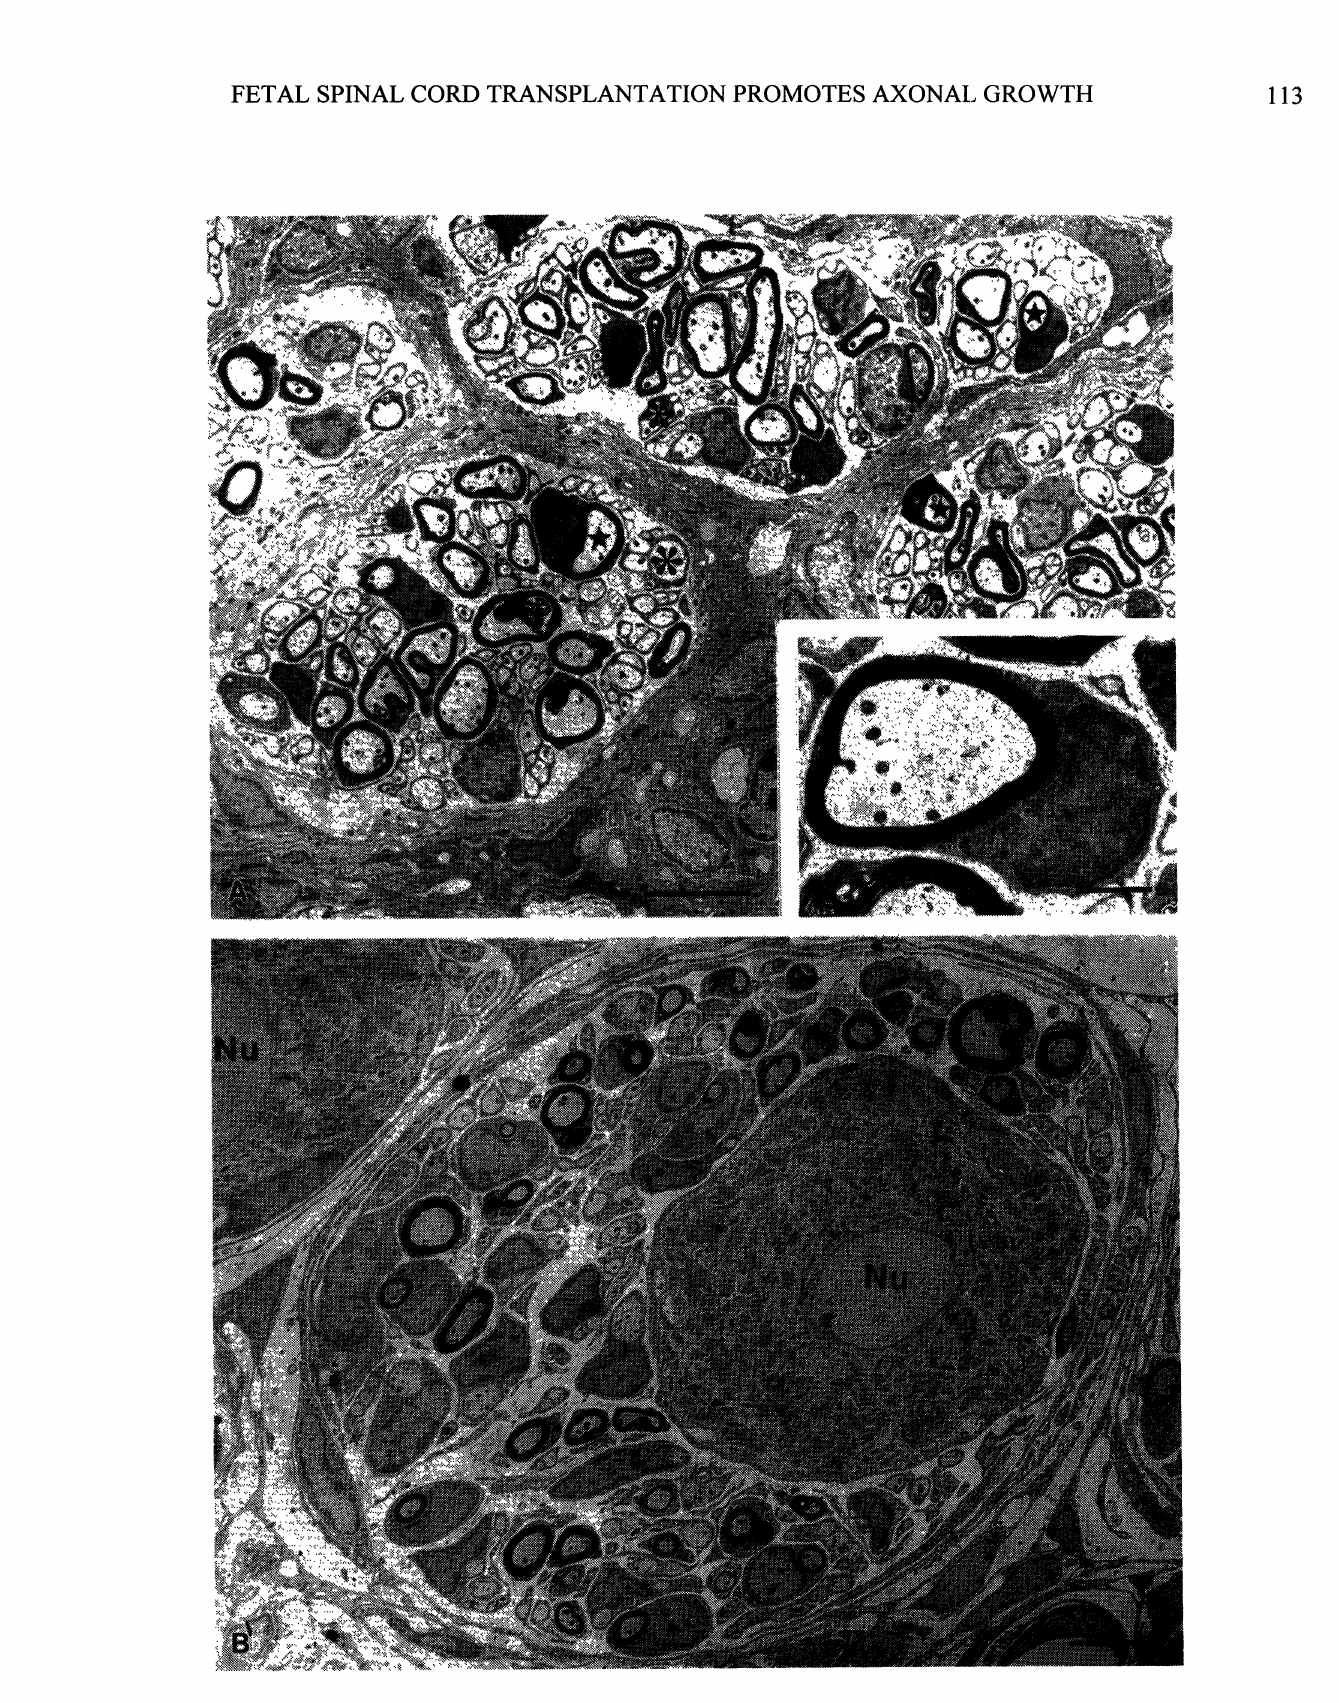
Fig. 6: A" Electron photomicrograph demonstrating many PNS-like fascicles of axons either myelinated (stars) or ensheathed (asterisks) by Schwann cells. Insert: a typical Schwann cell myelinating a single axon. B" Neuron-like cells (Nu) were found to exist within a PNS-like fascicle of axons. Bars: A-B 5tm; insert